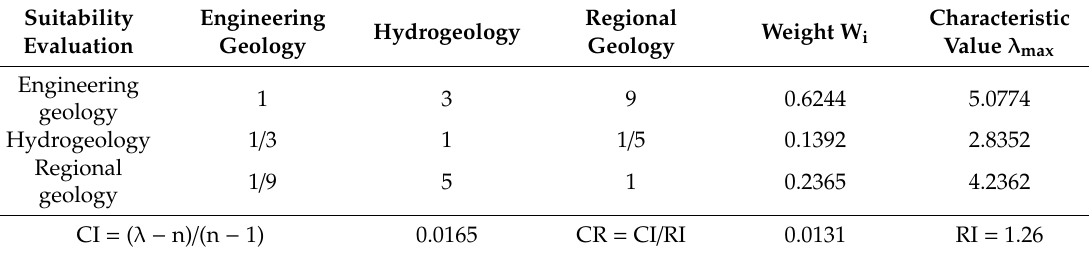
Table 3. Single ranking and consistency test of the criteria level judgment